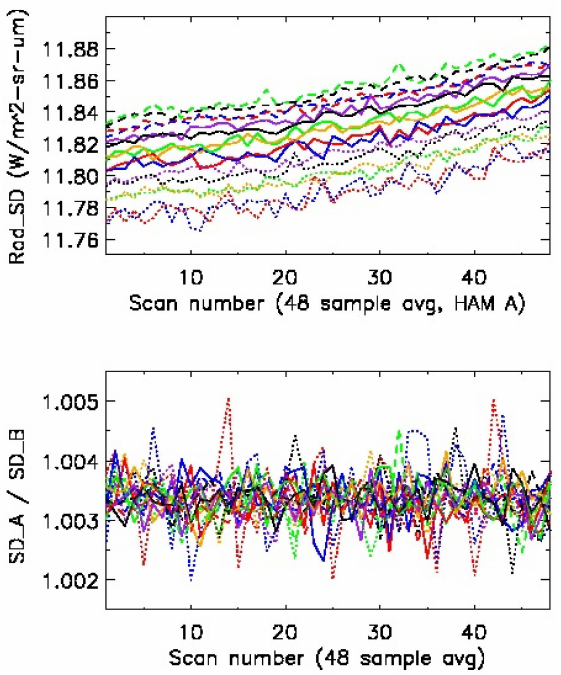
Figure 13. Detector dependent SD radiance for Half Angle Mirror (HAM) side A ( top ) and ratio of SD radiance between HAM sides A and B ( bottom ) in M15 on 30 June 2015. Each line represents a detector. Note: use 48-sample averaged value for each scan.